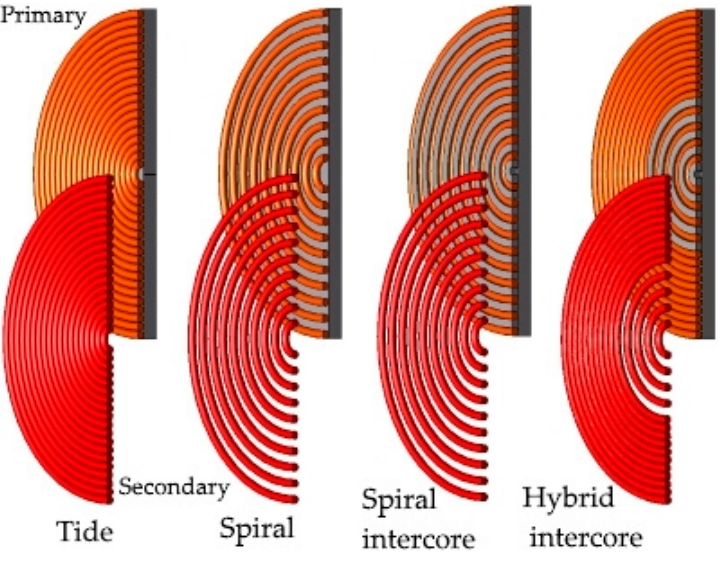
Figure 4. Diagram of four model types.